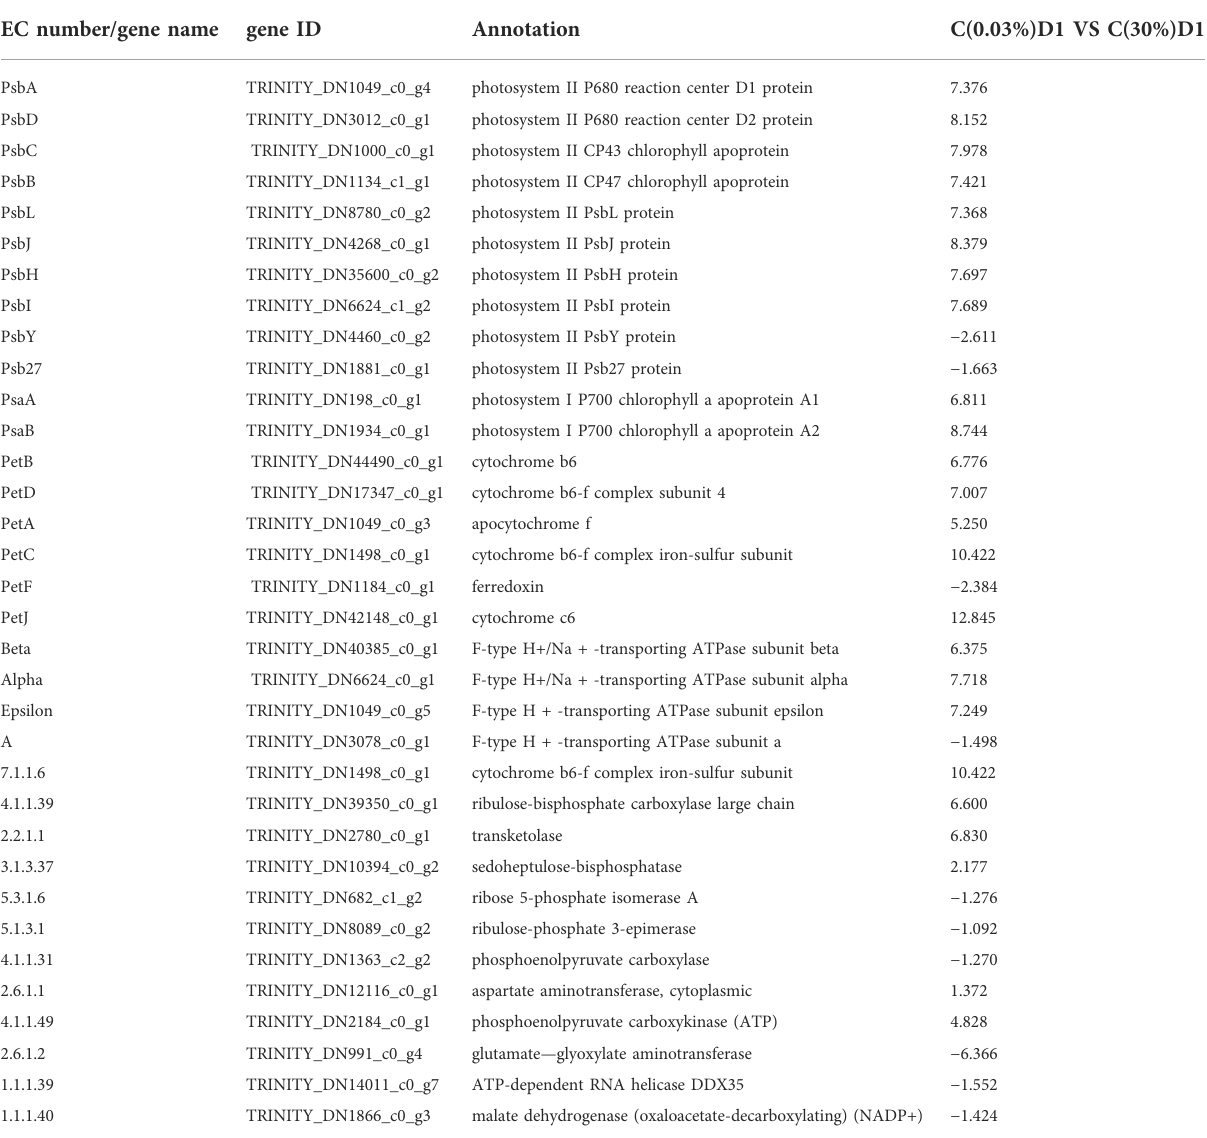
TABLE 1 Differential expression of key proteins in photosynthesis EC number/gene